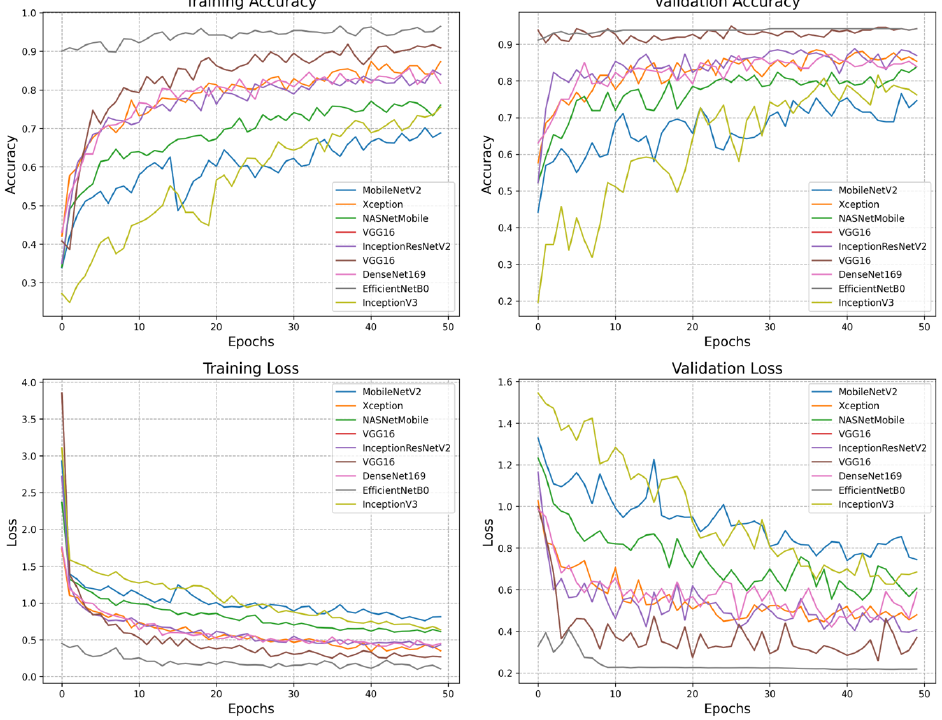
Figure 5. Accuracyandlosscurvesofproposedmodelsusedbasedonfine-tuningwithourproposedlayers.